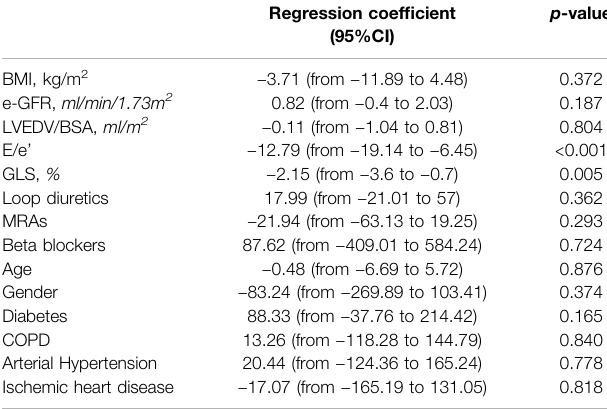
TABLE 4 | Multivariate linear mixed models of Cardiac Index over time. Regression coef fi cient